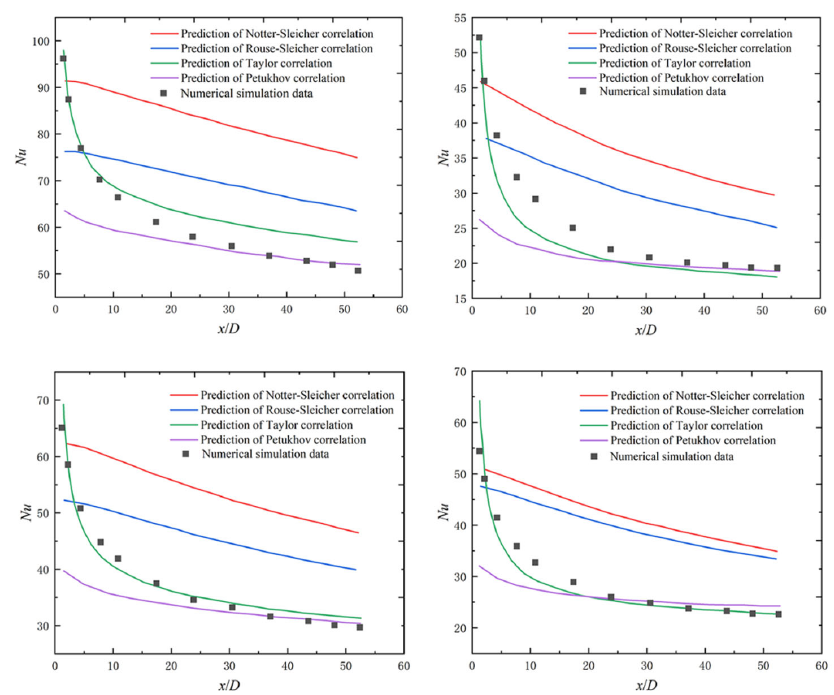
Figure 13. Verification of the applicability of variational Nusselt number correlations [14].